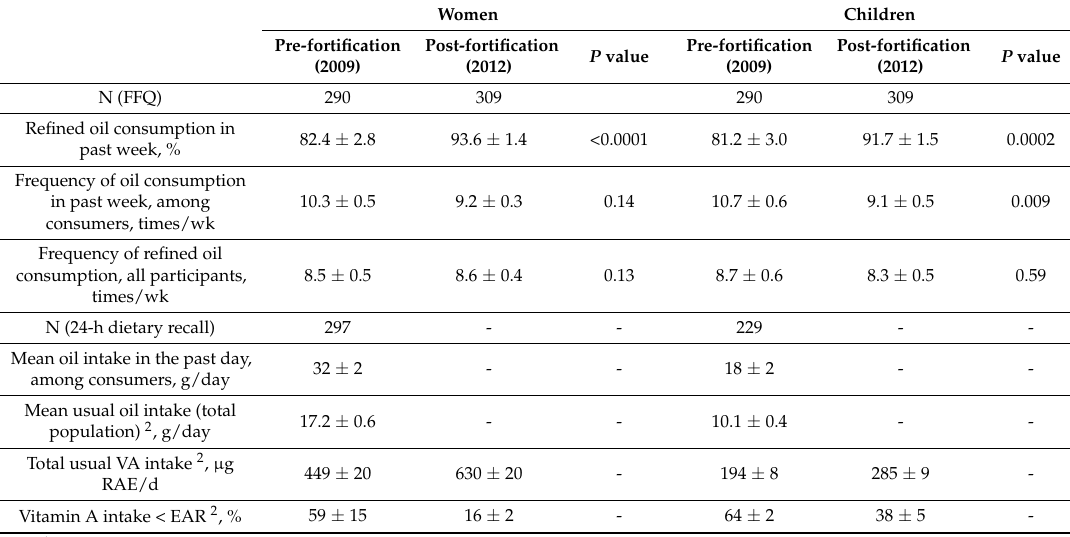
Table 3. Consumption of fortified foods and predicted change in the adequacy of micronutrient intake in Yaound é /Douala following the fortification of refined oil 1